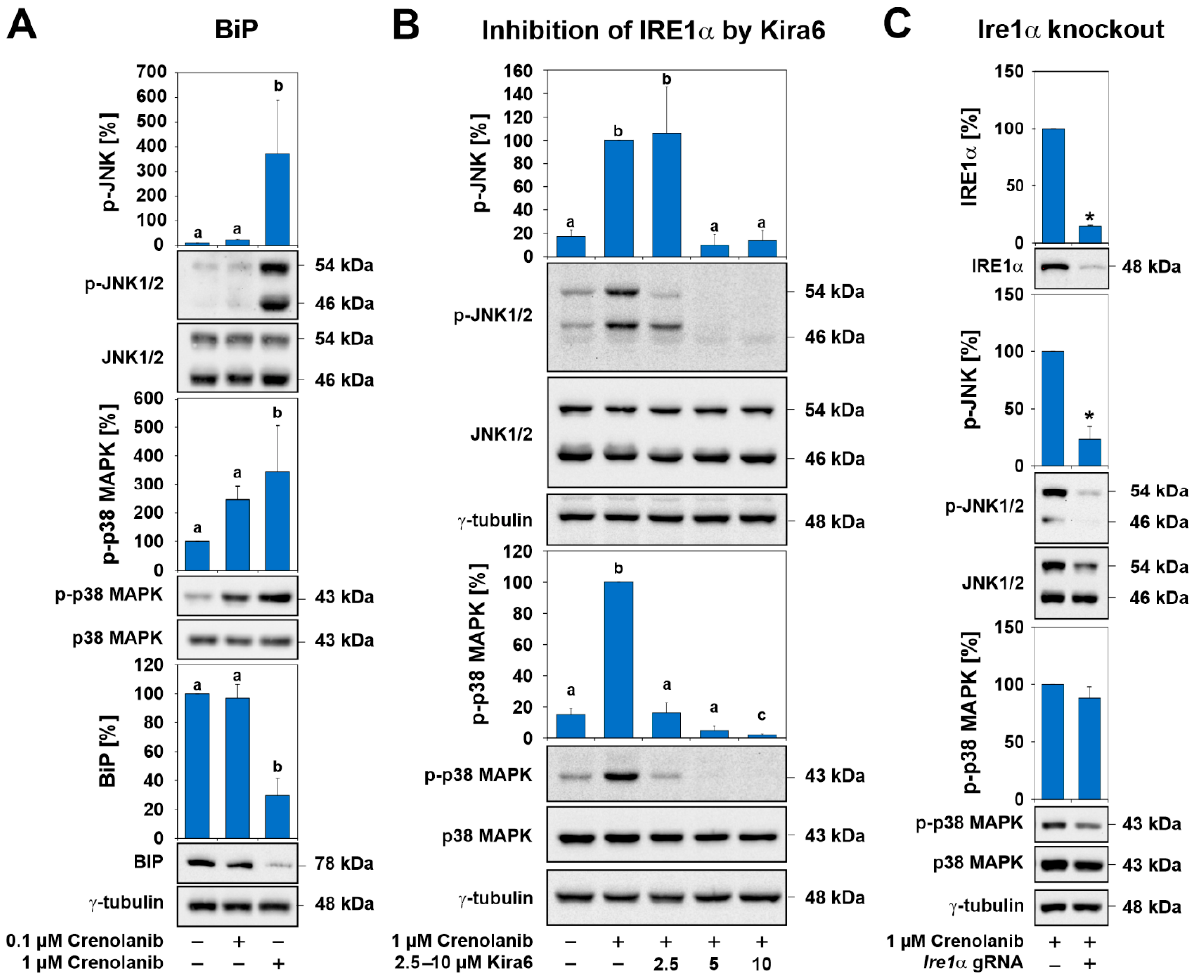
Figure 6. The effects of Crenolanib are mediated by a stress response via IRE1 α . ( A ) The stimulation of culture-activated HSC with 0.1 and 1 µM Crenolanib for 7 days and the subsequent analysis of p-p38 MAPK, p-JNK, and binding immunoglobulin protein (BiP) by Western blot. Long-term exposure of HSC to 1 µM Crenolanib significantly lowered BiP levels by 70%. At this concentration, Crenolanib has also the greatest impact on JNK and p38 MAPK activation. ( B ) The inhibition of IRE1 α by Kira6 in HSC significantly prevented the phosphorylation of p38 MAPK and JNK, as shown by Western blot analysis. ( C ) The CRISPR/Cas9 mediated knockout of Ire1 α in HSC significantly reduced the Crenolanib-mediated phosphorylation of JNK but not p38 MAPK in comparison to the mock control, which was set to 100%. For densitometry, the protein bands for total p38 MAPK, total JNK, and γ -tubulin were used as references ( n = 3; p < 0.05; significant differences are indicated by different letters or *asterisks).